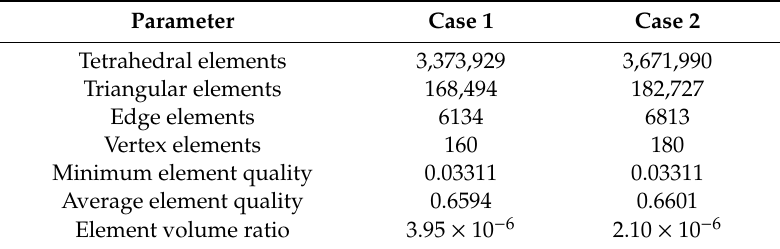
Table 5. Mesh details for Case 1 (single fault) and Case 2 (two faults).